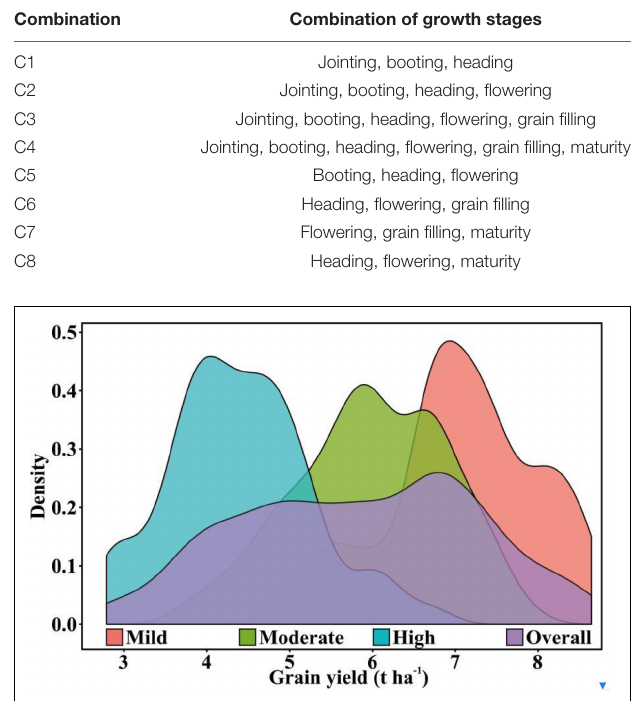
TABLE 4 | Combination of different growth stages used in the model for grain yield prediction.